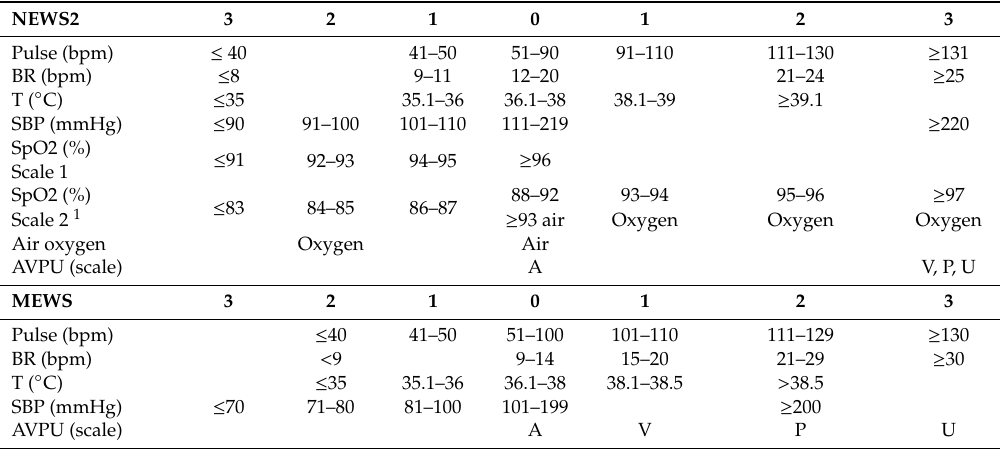
Table A1. Early Warning Score (EWS) analyzed in the